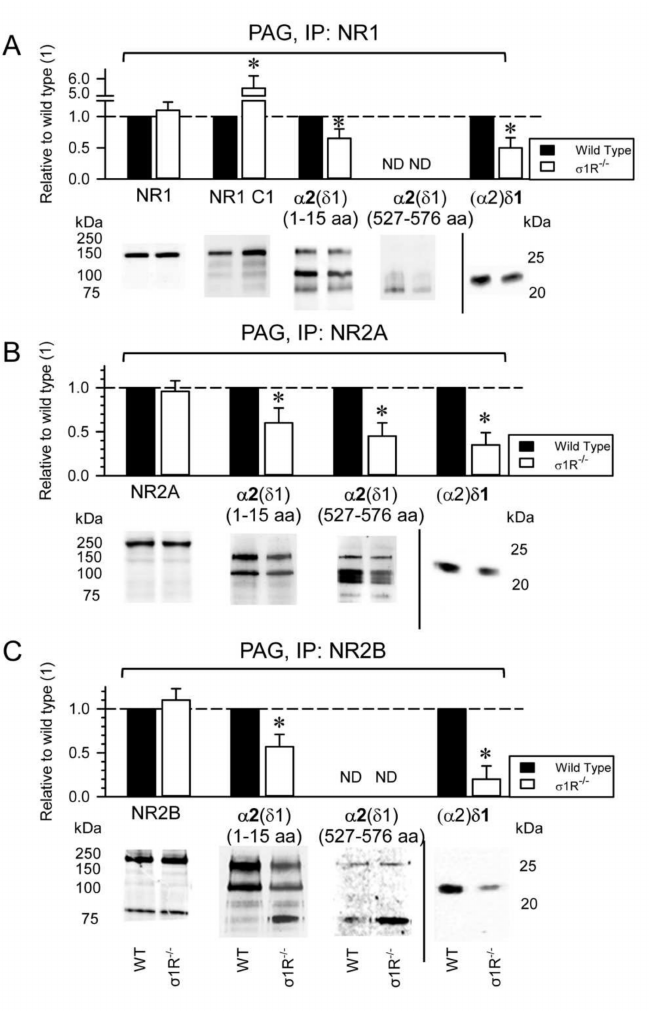
Figure 4. Influence of σ 1Rs on the presence of NMDAR- α 2 δ 1-2 complexes. CD1 WT ( n = 9) and CD1 σ 1R − / − ( n = 9) mice were sacrificed, and PAG synaptosomal fractions were prepared and solubilized. ( A ) NR1, ( B ) NR2A, and ( C ) NR2B subunits were immunoprecipitated (IP) from PAG solubilized proteins. Co-precipitated α 2 δ 1 protein was detached from the NMDAR bait subunits and the presence of α 2( δ 1) and ( α 2) δ 1 was analyzed in Western blots. The bars represent the mean ± SD from three assays carried on tissue obtained from different groups of three mice. Data from the CD1 σ 1R − / − mice are relative to the CD1 WT control, which was assigned an arbitrary value of 1: * indicates significant differences relative to the WT control group, p < 0.05 (representative Western blots are shown, see Section 2 for further details). ND: not determined because of a weak